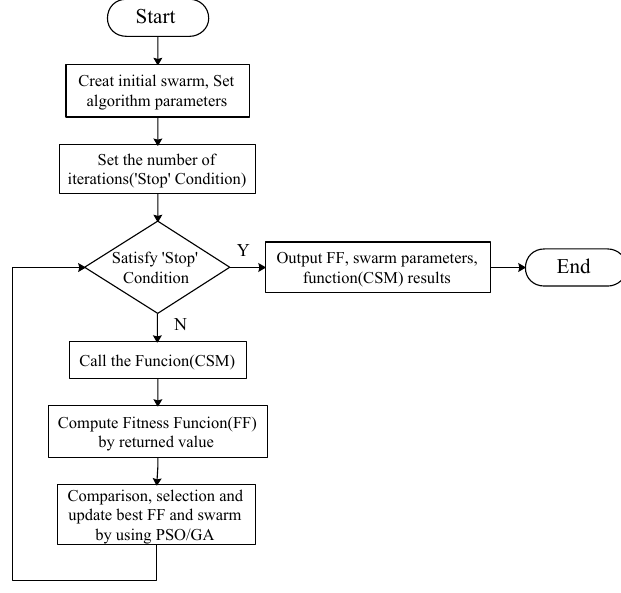
Figure 5. The flow chart of the optimized charge simulation